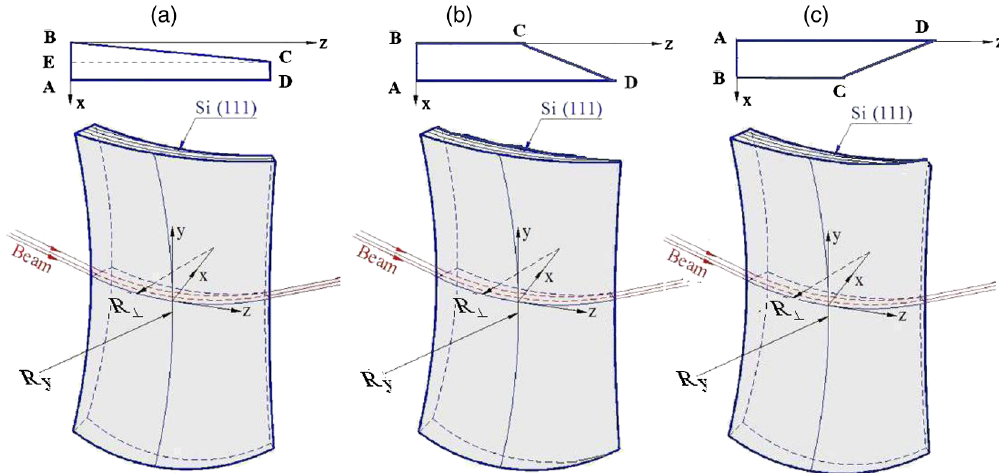
FIG. 1. The bent crystals used for the measurements: (a) focusing crystal in the previous experiment [17], (b) focusing, and (c) defocusing crystals used in the present experiment. R y is the radius of the vertical bending, and R ⊥ is the radius of the bending in the horizontal plane, which provides the particle beam